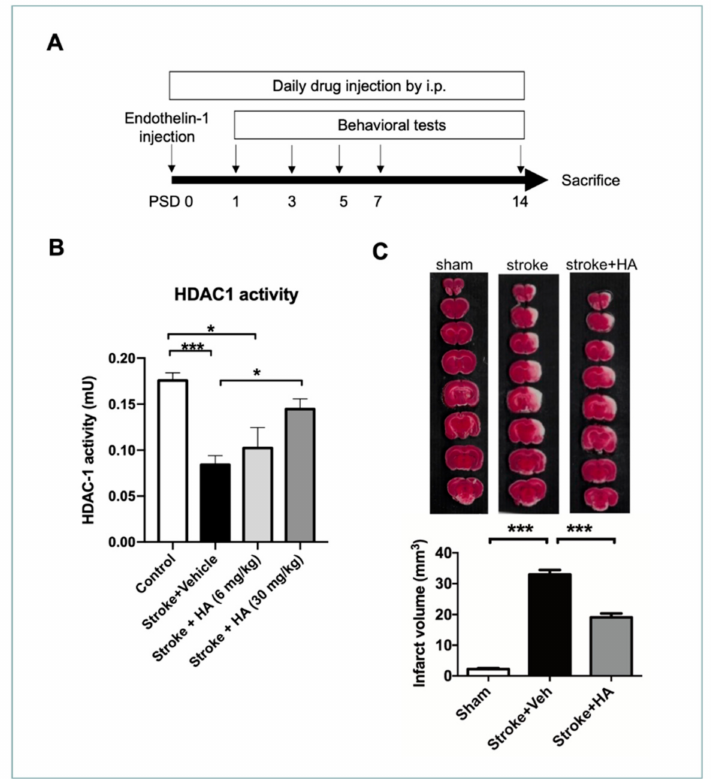
Figure 3. HA treatment attenuated HDAC1 enzymatic dysfunction and ischemia volume of the brain in rats. ( A ) Flow chart of experimental design in vivo. ( B ) HDAC1 enzymatic activity assay for evaluation of the dose–effect of HA. n = 6 ( C ) Representative figures of TTC staining that were conducted at post-stroke day 3 in rats with endothelin-1-induced brain ischemia. Quantified data of ischemia volume from rats with brain ischemia. n = 8. * Denotes p < 0.05; *** denotes p <